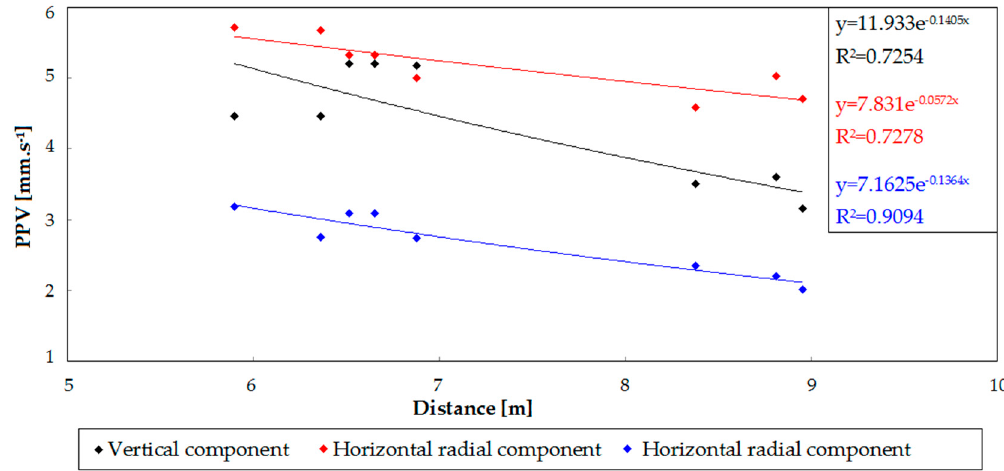
Figure 9. Attenuation curves for the given environment acquired pursuant to in situ measurement— sheet piles.